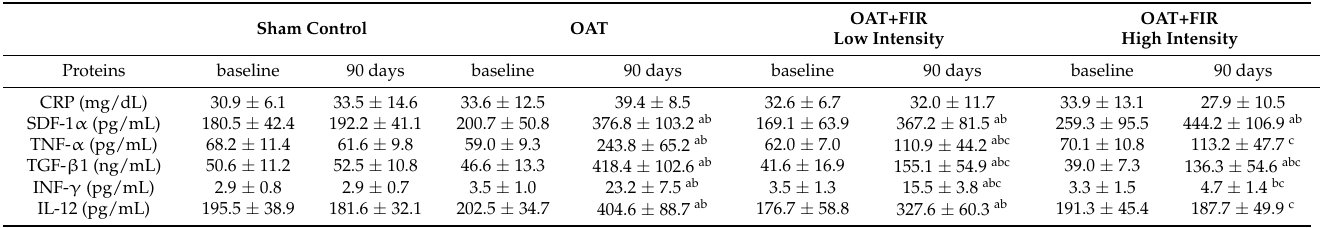
Table 3. Comparison of OAT vasculopathy-related factors in ACI/NKyo rats ( n =